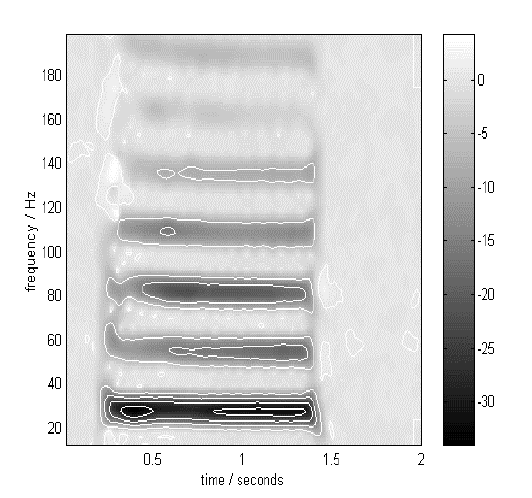
Fig. 9. Differential time-frequency map showing the difference in response measured at the top and bottom of the model i.e. between the maps in Figs 6(A) and 8(A).